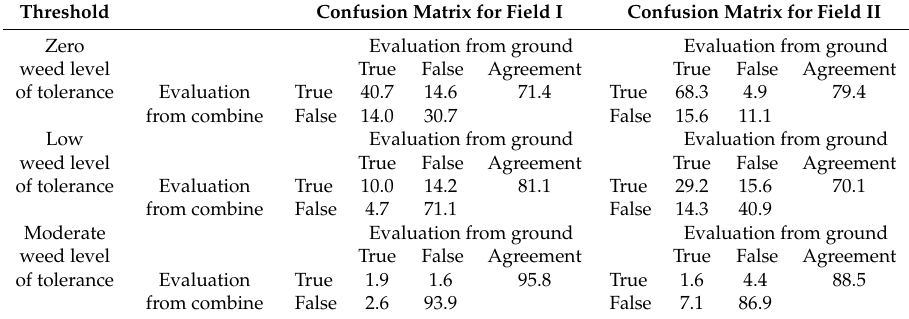
Table 1. Confusion matrix of the two reference maps (evaluation from the ground and evaluation from the combine) for different thresholds for Fields I and